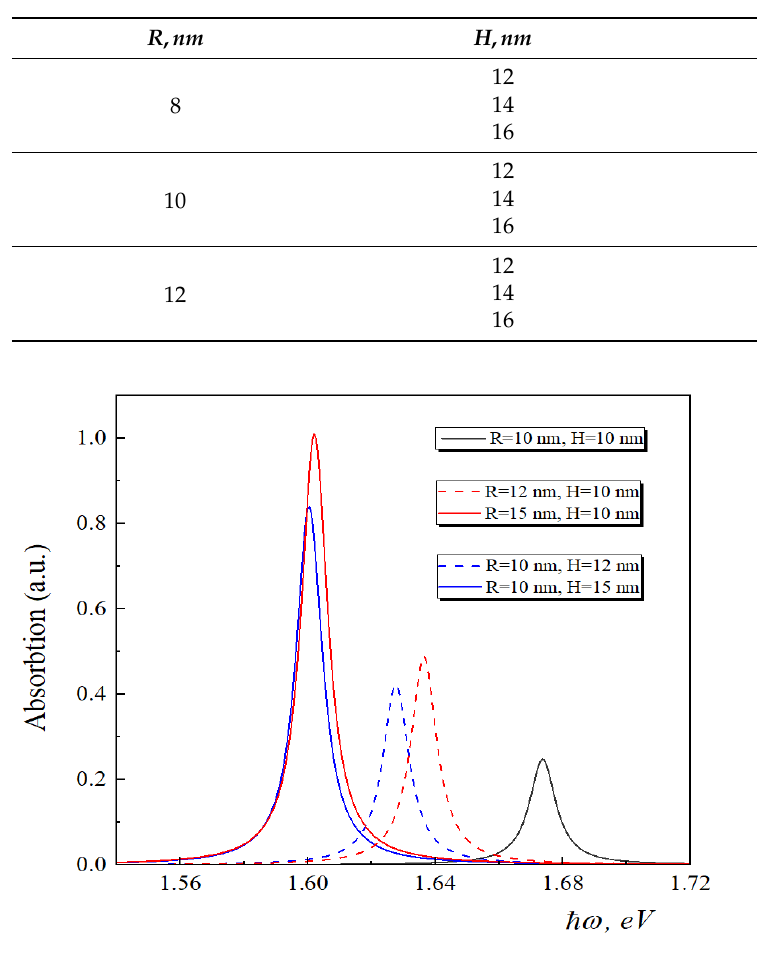
Figure 5. Dependence of the absorption lines on the energy of the incident light for various sizes of conical QD for the quantum transition from the ground state to the first excited state.